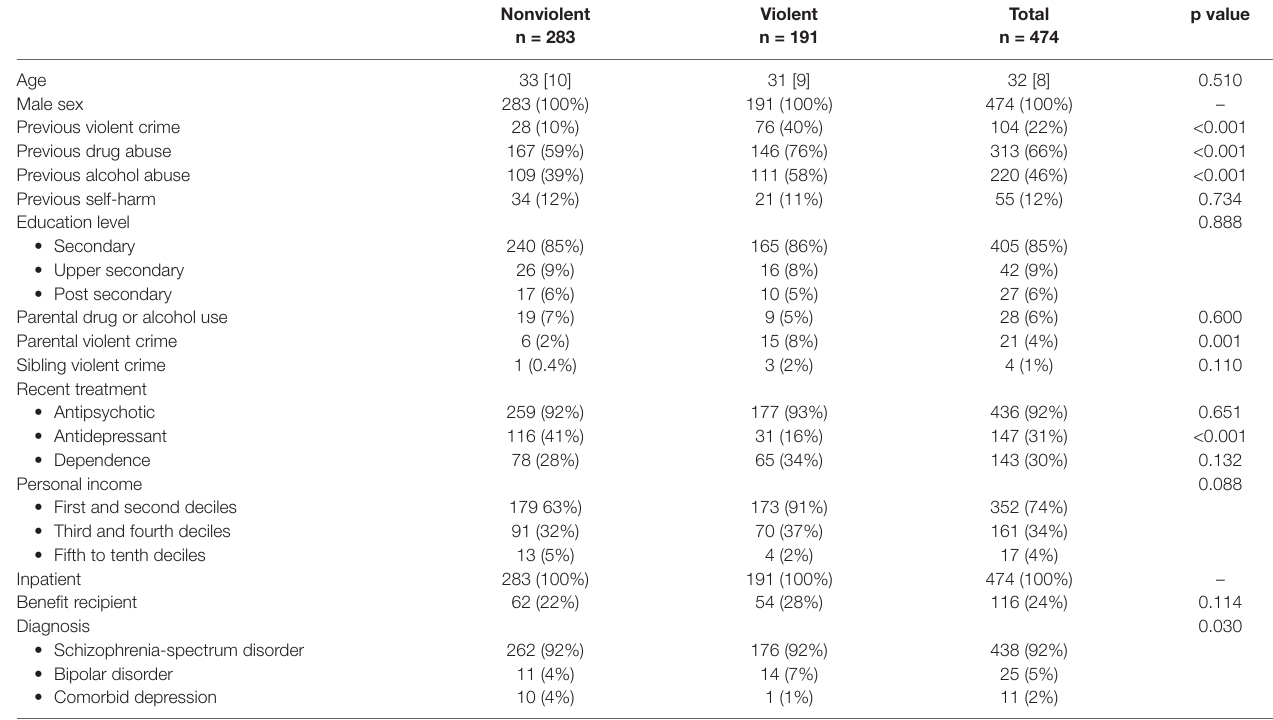
TABLE 1 | Descriptive data from the nonviolent and violent groups in the Berlin prison hospital divided into risk